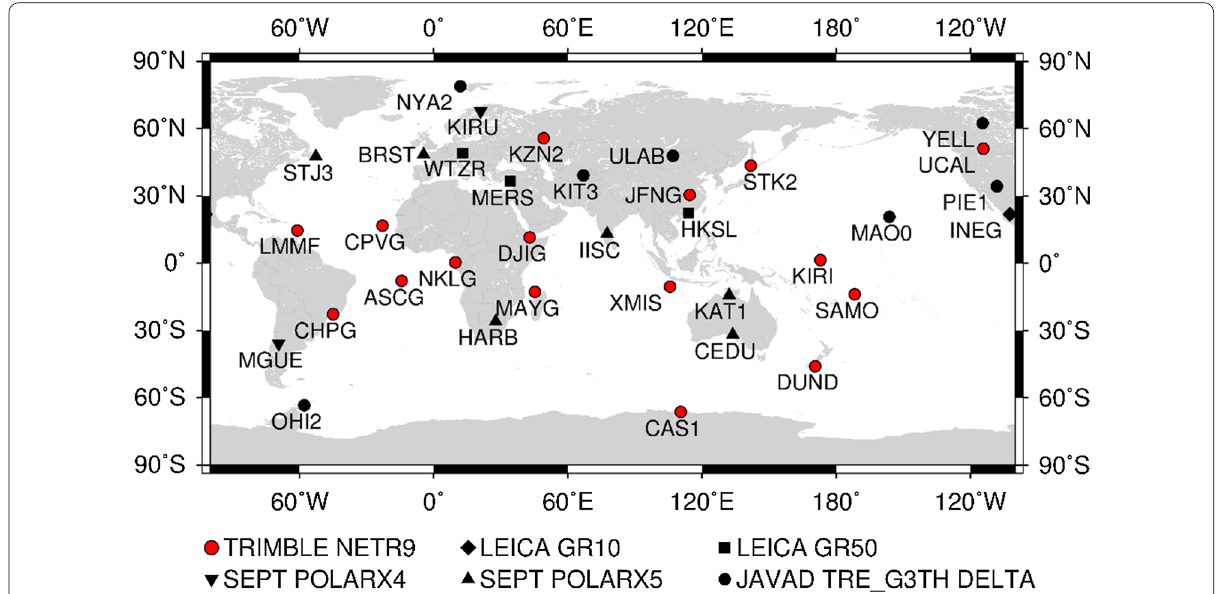
Fig. 2 Geographical distribution of 35 MGEX stations for SPP and PPP and their receiver type during DOY 200–206 of 2018